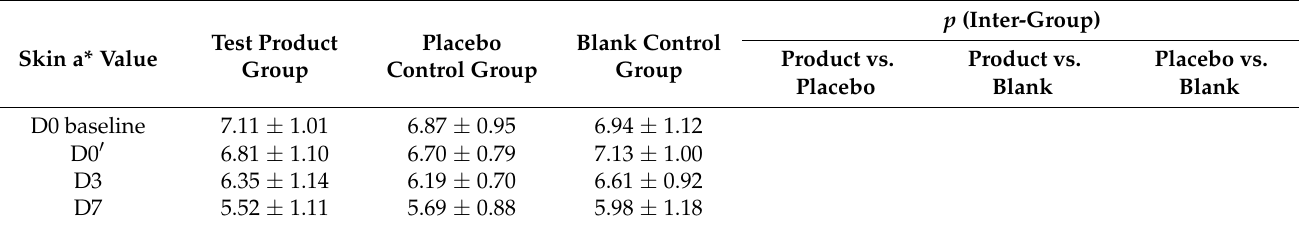
Table 2. Difference analysis of skin a*